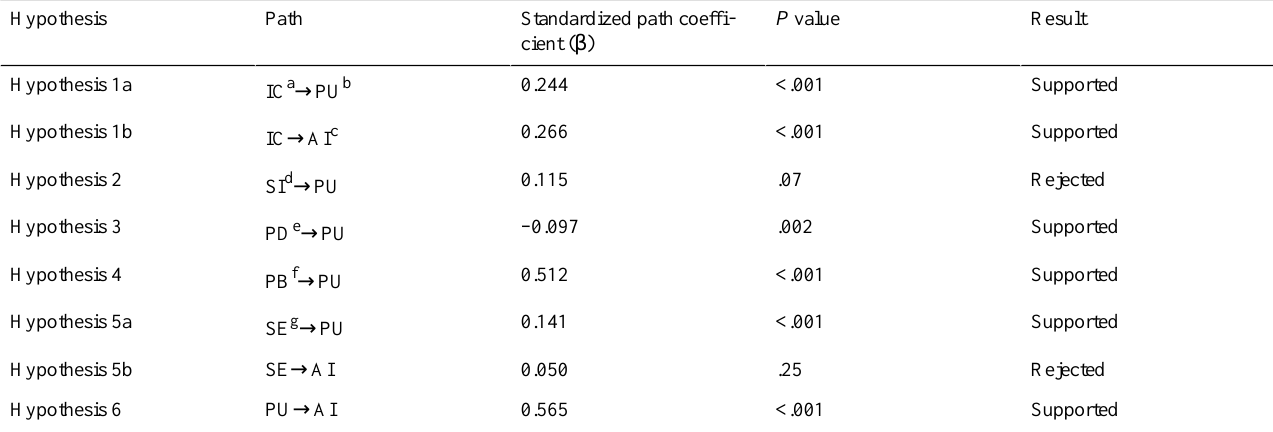
Table 6. Testing results of the hypotheses.